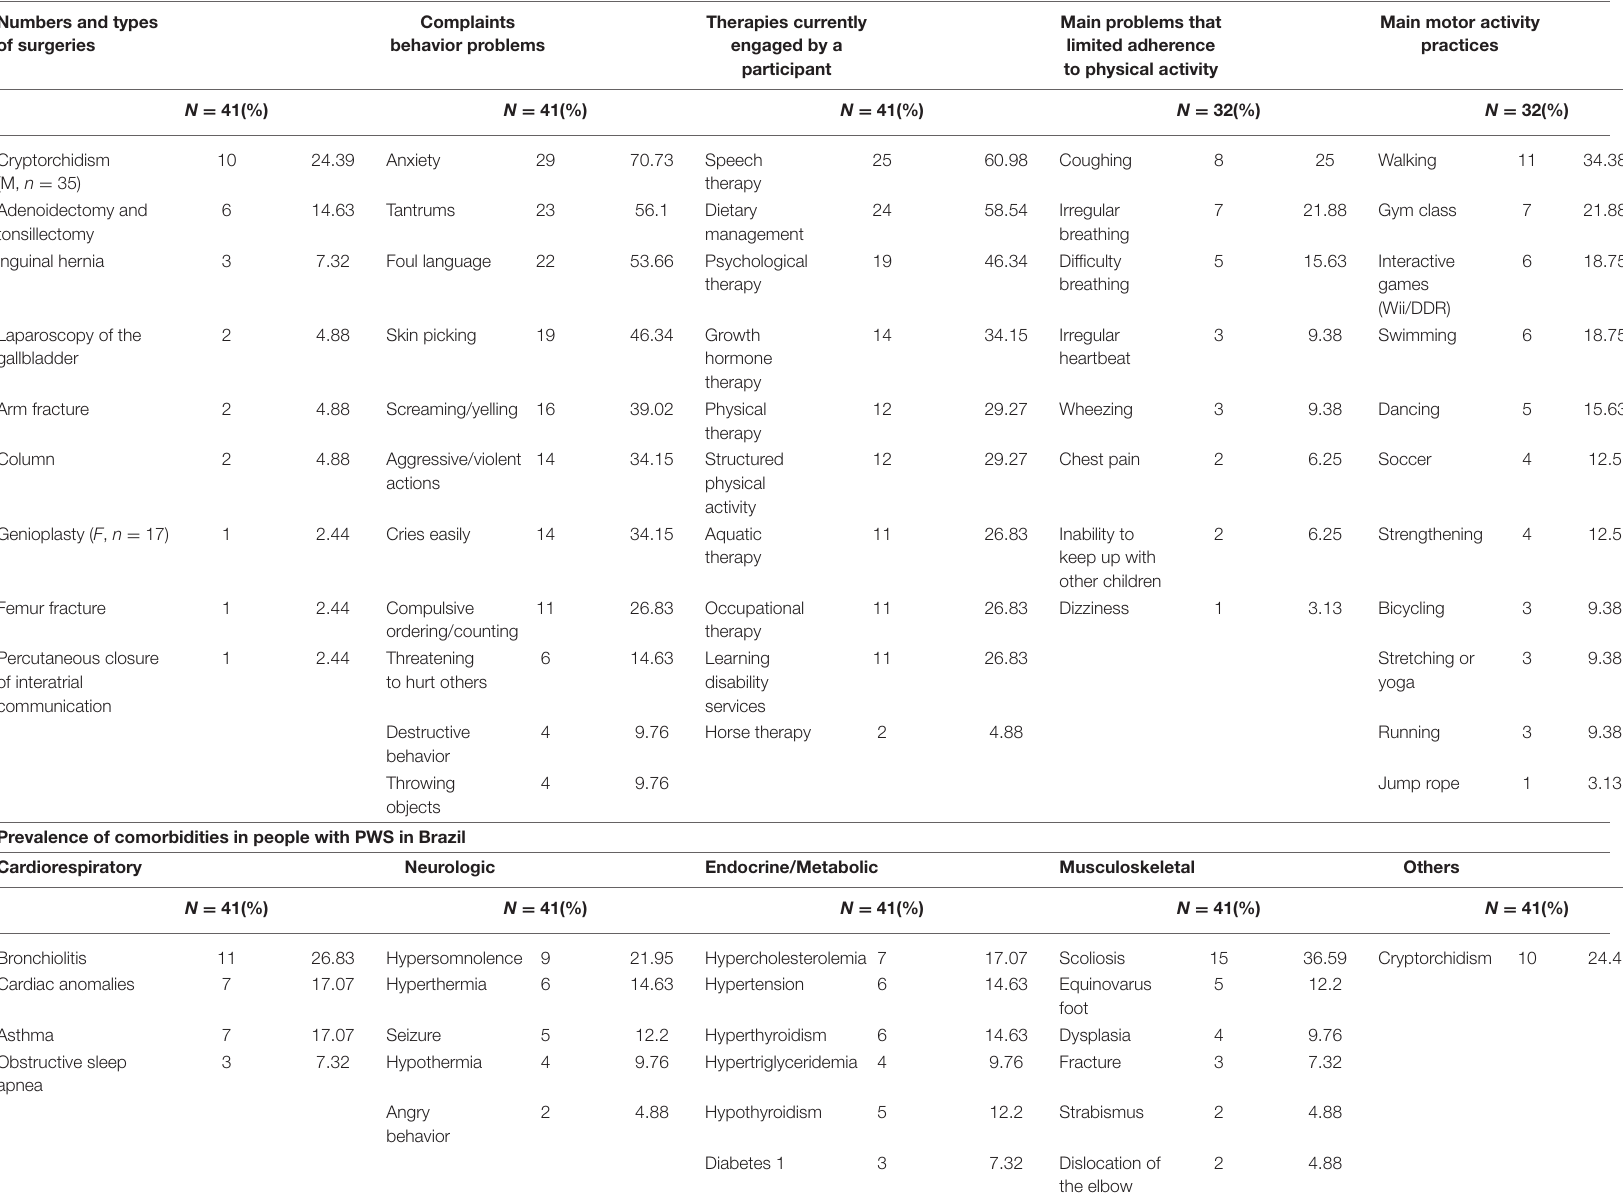
TABLE 3 | Main surgery cases, frequency of behavioral problems, therapies used, physical activities problems, and